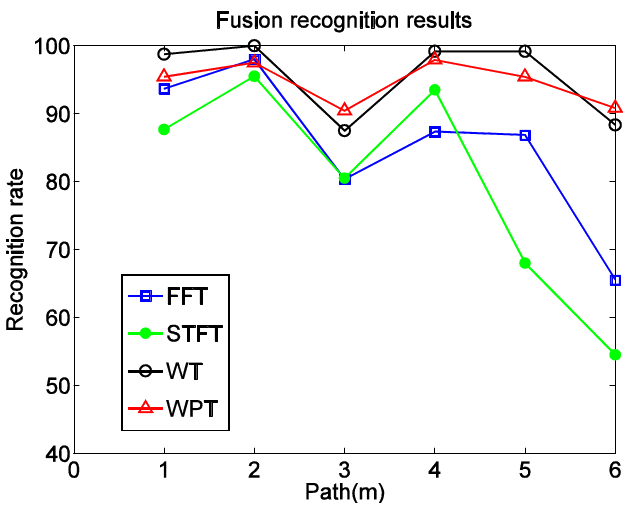
Figure 12. The results of FCEM fusion recognition.